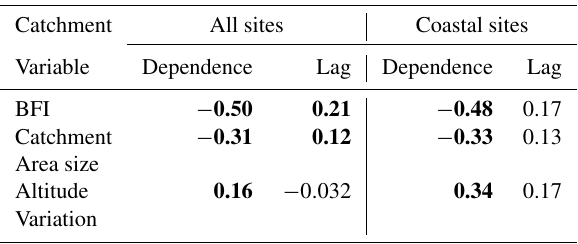
Table 4. Correlation between catchment variables and (i) the num- ber of joint occurrences per decade between high skew surges and river discharge and (ii) the lag day when there is the maximum num- ber of joint occurrences between high skew surge and high river discharge. Bold text indicates statistical significance at a 95% con- fidence